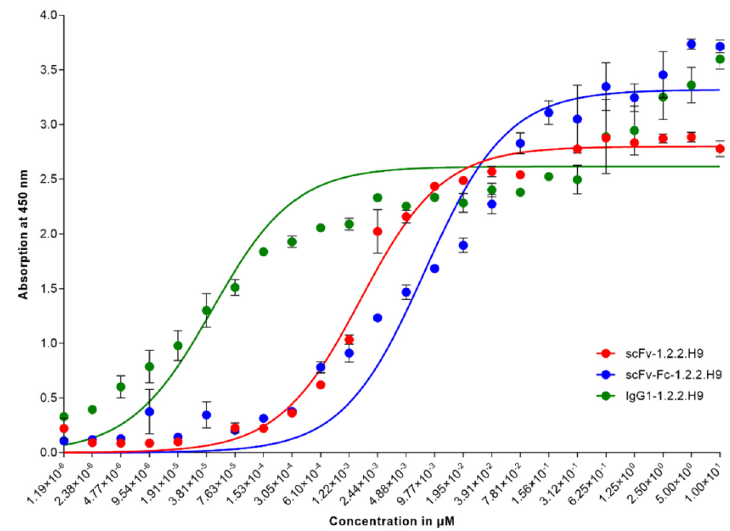
Figure 4. Indirect ELISAs with scFv-1.2.2.H9, scFv-Fc-1.2.2.H9, and IgG1-1.2.2. H9 on 2 µg/mL VACV Elstree in triplicates. The titration was performed in twofold serial dilutions. The starting concentrations were 10 µM of purified antibodies. The solid lines represent the interpolated curves used to calculate the binding kinetics according to Michaelis-Menten.